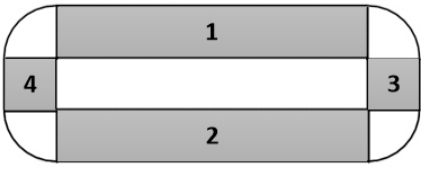
Figure 5. Top view of the racetrack